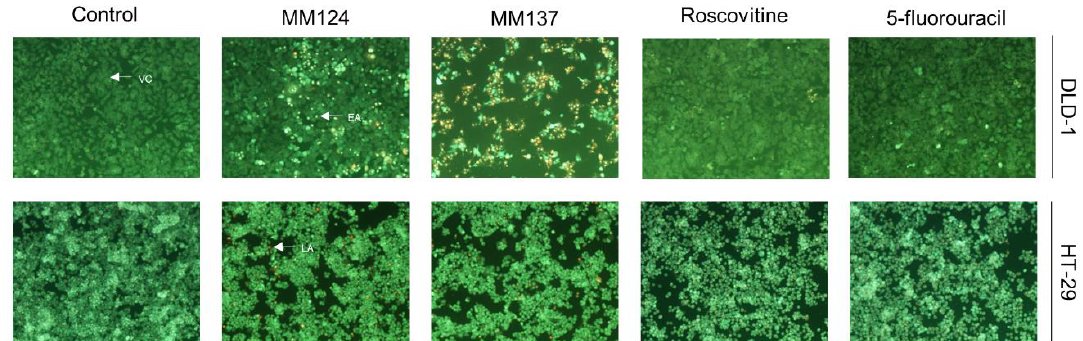
Figure 4. Induction of apoptosis in human HT-29 and DLD-1 cells incubated for 24 h with novel 7-methyl-5-phenyl-pyrazolo[4,3- e ]tetrazolo[4,5- b ][1,2,4]triazine sulfonamide derivatives (MM124, MM137), 5-fluorouracil and roscovitine at 0.5 µM, Concentration was evaluated by a fluorescent microscopy after acridine orange and ethidium bromide staining.